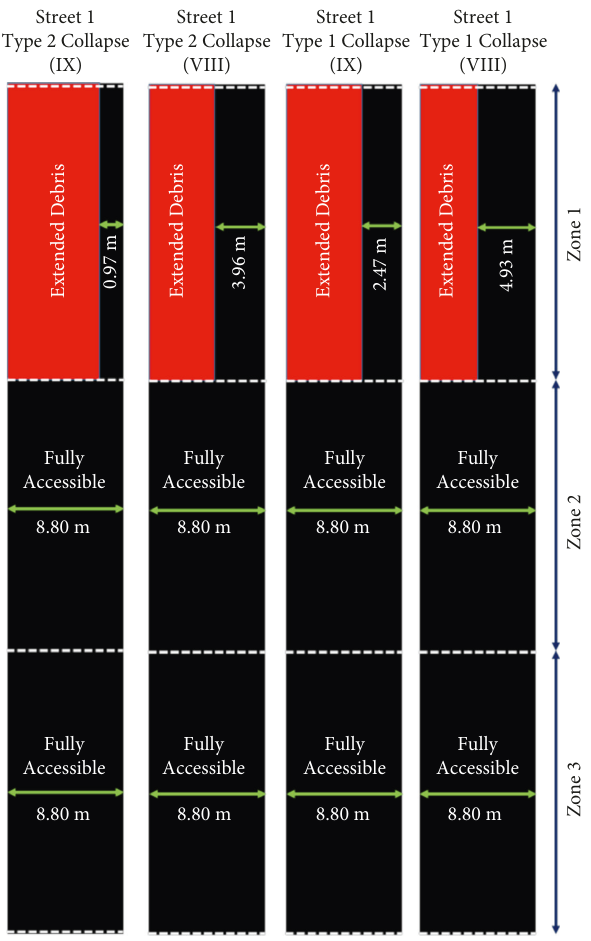
Figure 9: Representative figure for the obstructed zones of street number 1.